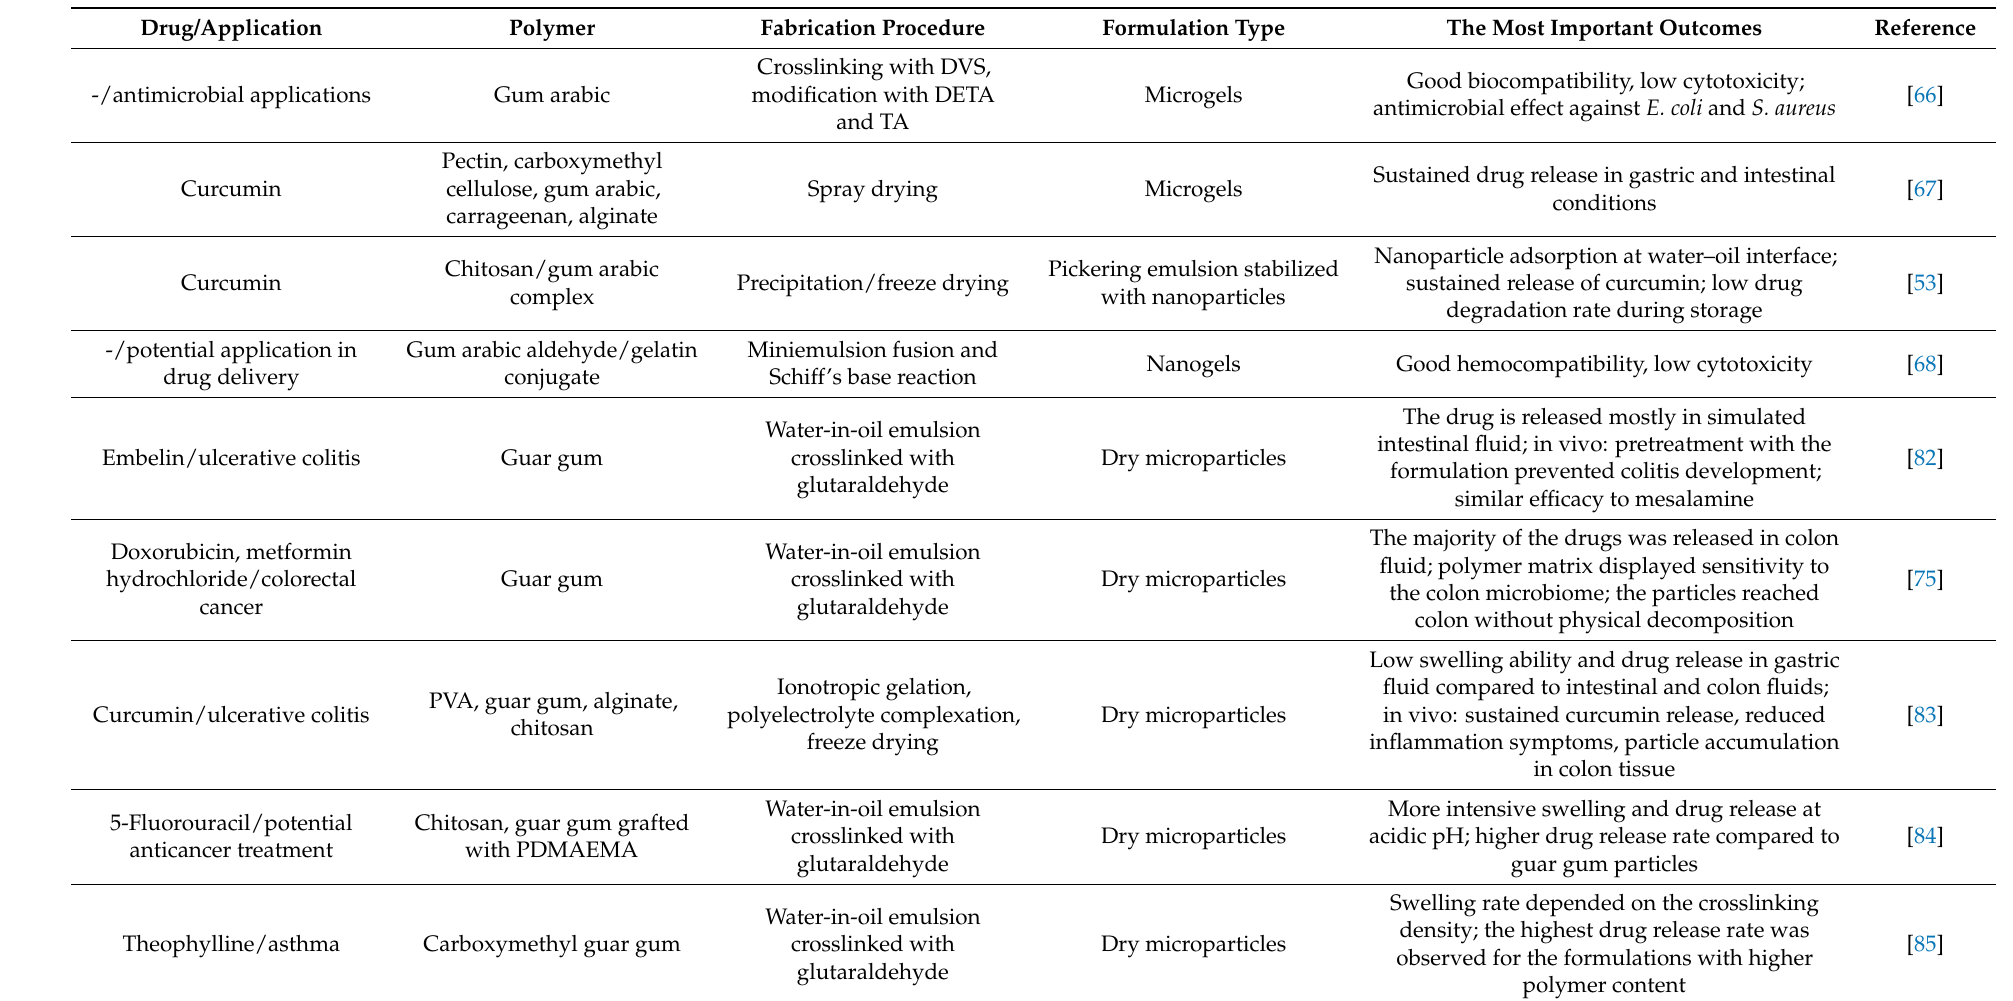
Table 1. The examples of natural gum-based micro- and nanoparticulate